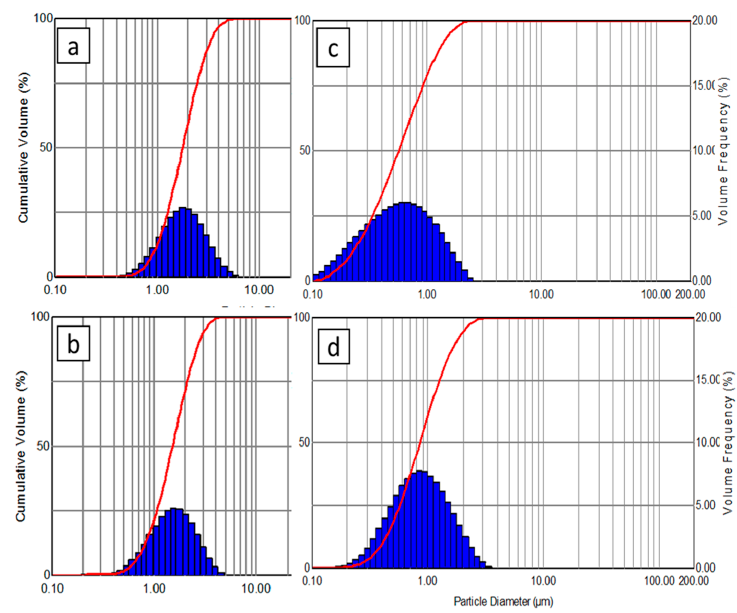
Figure 4. Particle size distribution of ( a ) C1, ( b ) C2, ( c ) HM1 and ( d ) HM2.